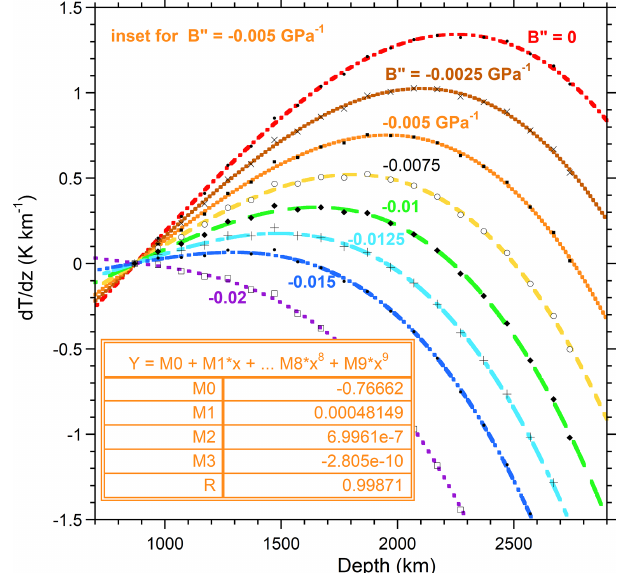
Figure 6. Dependence of thermal gradients from PREM (black symbols) on depth and the choice of ∂ 2 B/∂P 2 for LM ma- terial. Fits are in color, where the inset lists coefficients for B (cid:48)(cid:48) =− 0.005GPa − 1 , which has a typical residual. For positive gra- dients, T increases